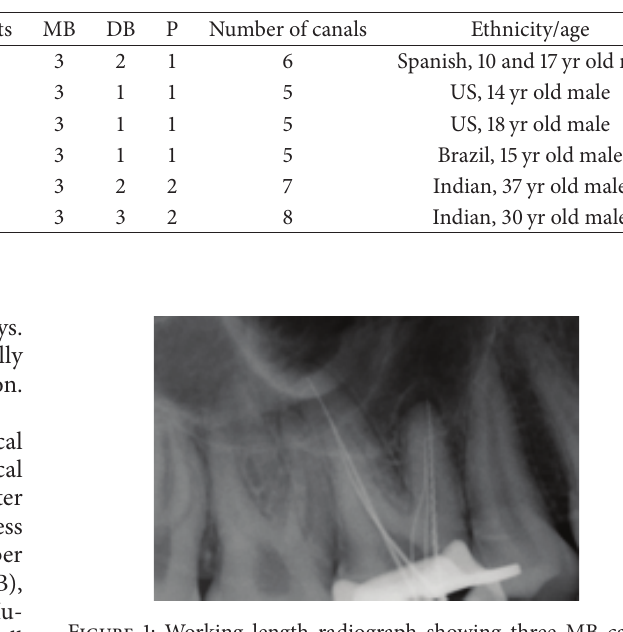
Figure 1: Working length radiograph showing three MB canals. MB3 joining the MB2 at middle third.